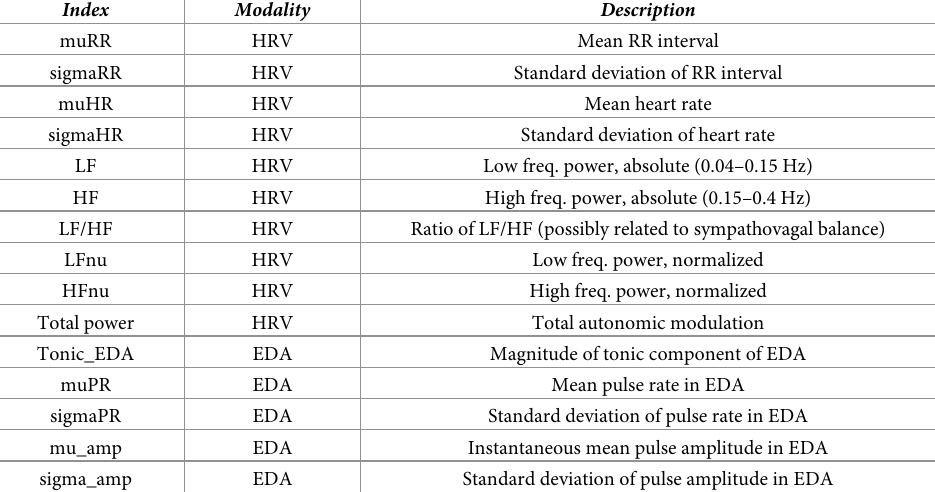
Table 1. Summary of point process autonomic